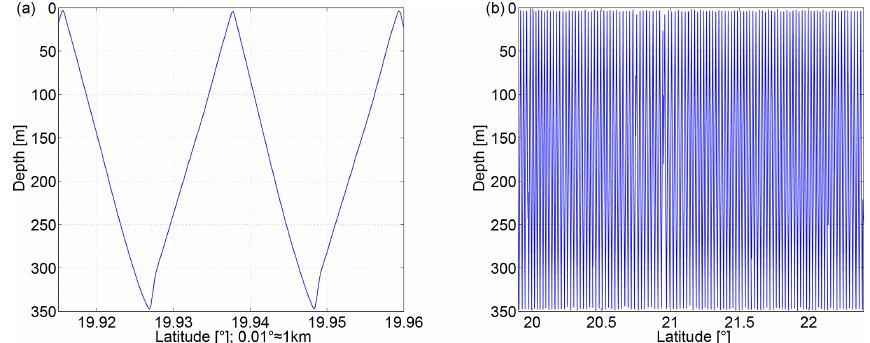
Figure 1. Sawtooth pattern of observations: (a) shows an exemplary subset of the down- and upcasts and (b) shows all 110 used undulations of the section from 30 May 17:30 to 31 May 2018 16:00UTC. The distance between consecutive downcasts is ≈ 2 .